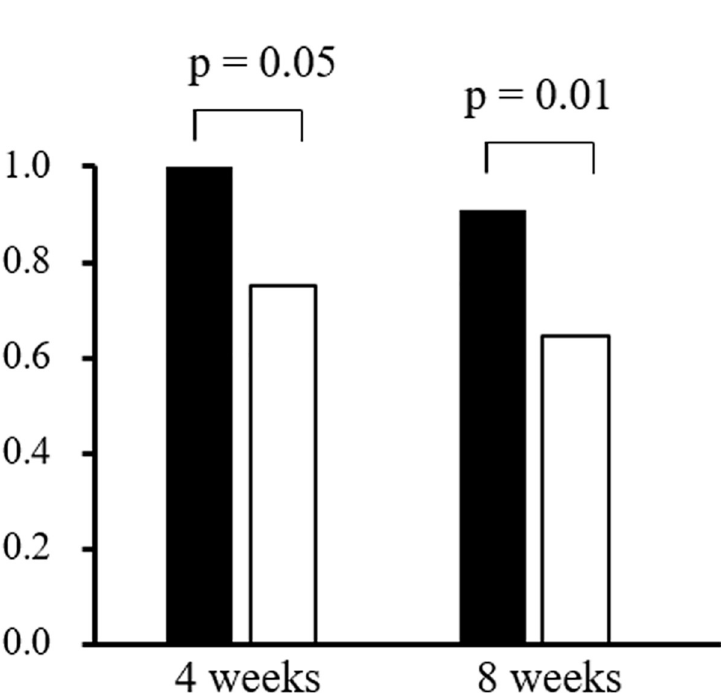
Fig 2. Relative dose intensity (RDI) of lenvatinib at 4 and 8 weeks. White bar showed the median value in the high CRP group and the black bar shows that of the low CRP group. RDI in the high and low CRP groups was 0.75 and 1.00 at 4 weeks, and 0.65 and 0.91 at 8weeks, respectively. Although the p value of RDI at 4 weeks was 0.054, it was 0.01 at 8 weeks by Mann-Whitney’s U